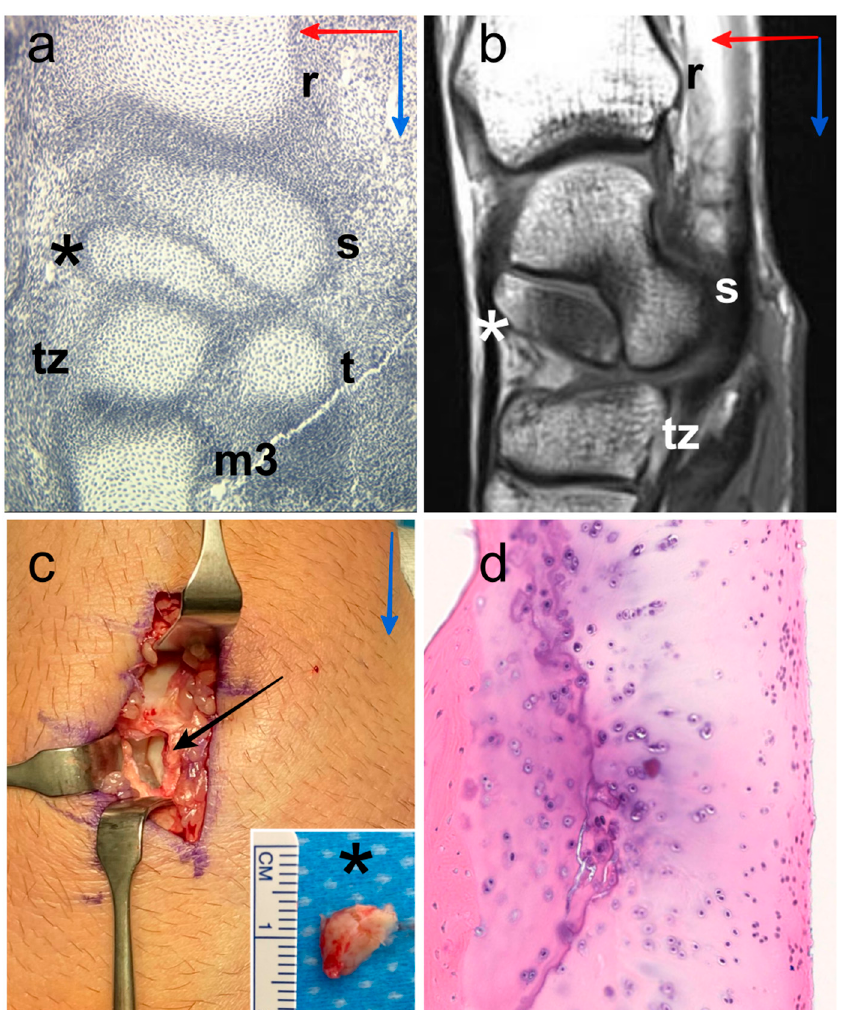
Figure 1. Digital image of histological section of the wrist of human embryo with a crown-rump length of 19 mm, location of the centrale nodule (black asterisk), scaphoid (s), radius (r), trapezium (t), trapezoid (tz) and third metacarpal bone (m3). Proximo-distal direction (blue arrow) and antero- posterior direction (red arrow) ( a ). Representative MR image (36-year-old human male), sagittal T1-weighted TSE, location of the os centrale (white asterisk), scaphoid (s), radius (r) and trapezoid (tz). Proximo-distal direction (blue arrow) and antero-posterior direction (red arrow) ( b ). Intraoperative photographs of the posterior aspect of the wrist (47-year-old human male) showing the os centrale (black asterisk) after excision (black arrow), we can observe the cartilaginous surface of the scaphoid in relation to the os centrale. Proximo-distal direction (blue arrow) ( c ). Histology confirmation of the presence of the hyaline cartilage structure all around the os centrale ( d ).